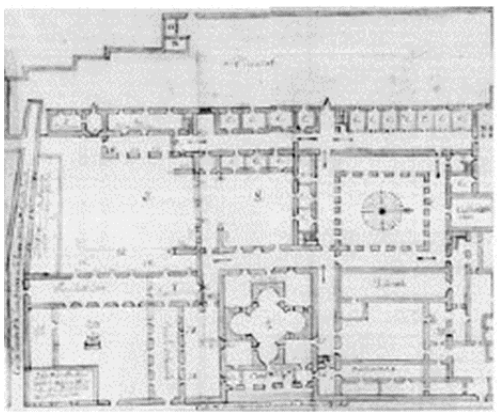
Figure 2. Plan of the Royal Convent of San Diego in Seville (1784), formerly known as the Novitiate of San Luis. Archivo Histórico Nacional. Consejos nº 1423.